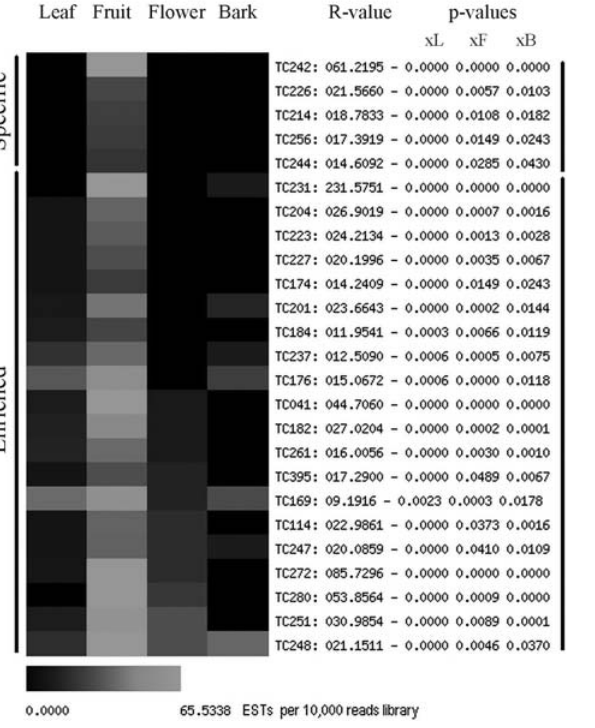
Figure 2 - Digital expression profile of the 25 differentially expressed clusters in flavedo. Relative abundance of each cluster is graphically